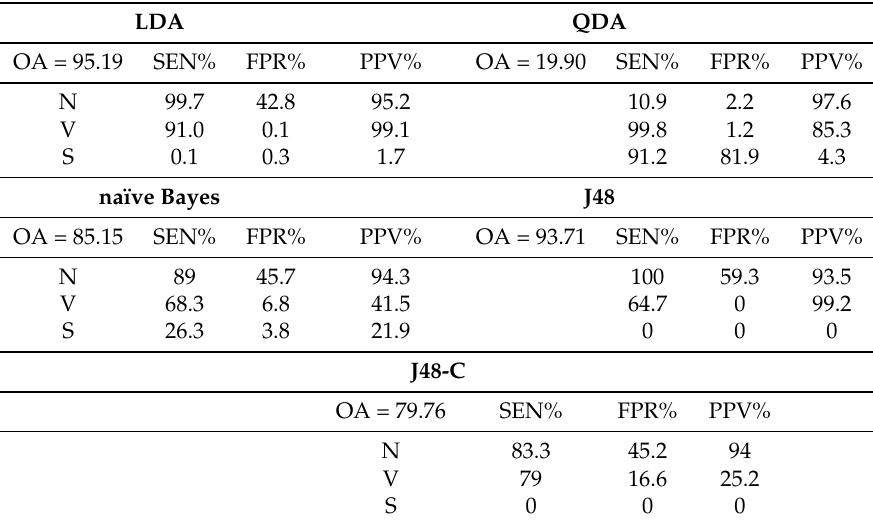
Table 17. Performance measures for various classifiers (N,V, S classes).